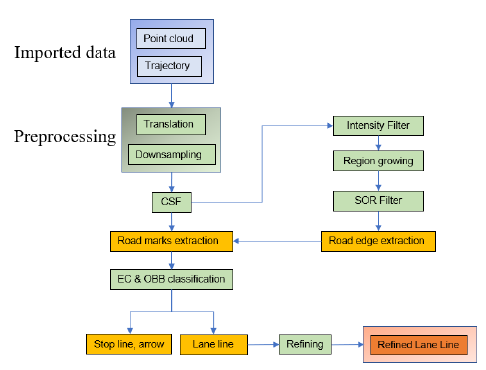
Figure 3. The flowchart of extraction algorithm.